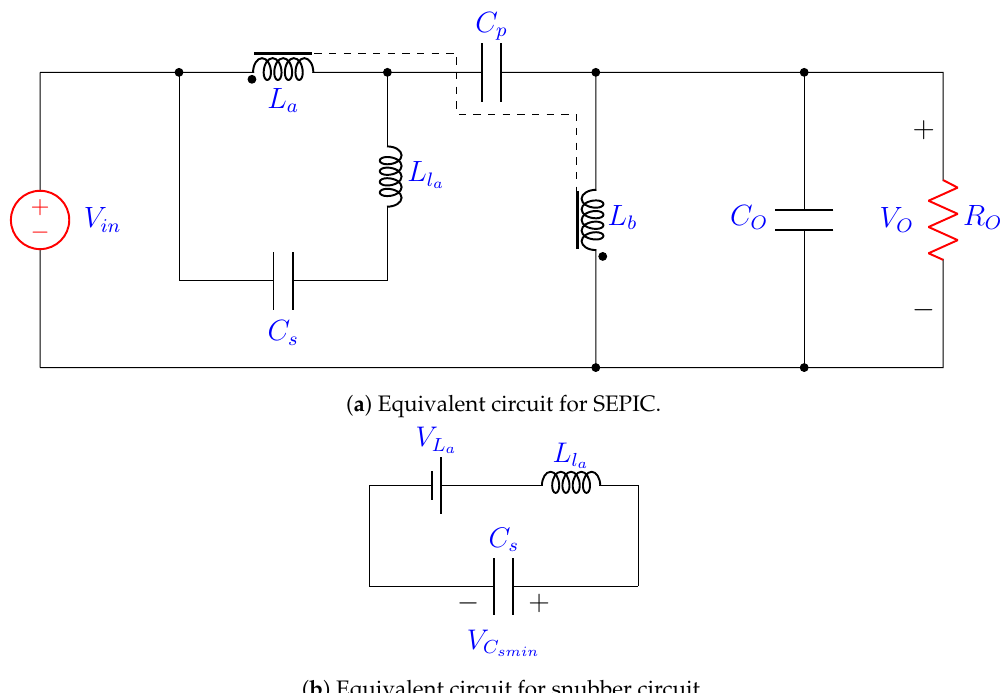
( b ) Equivalent circuit for snubber circuit. Figure 6. Equivalent circuit at the first state in the turn OFF period for SEPIC and snubber